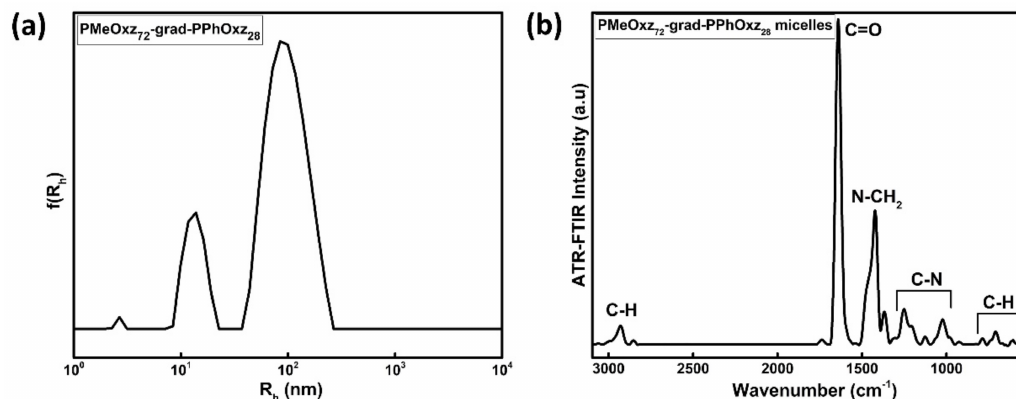
Figure 1. ( a ) Size distribution from Contin of PMeOxz 72 -grad-PPhOxz 28 GC at 90 ◦ in aqueous solutions using the TFHM, ( b ) ATR-FTIR spectra of PMeOxz 72 -grad-PPhOxz 28 nanoassemblies in aqueous solutions using the TFHM. Table 2. DLS and ELS results for the PMeOxz 72 -grad-PPhOxz 28 copolymer and